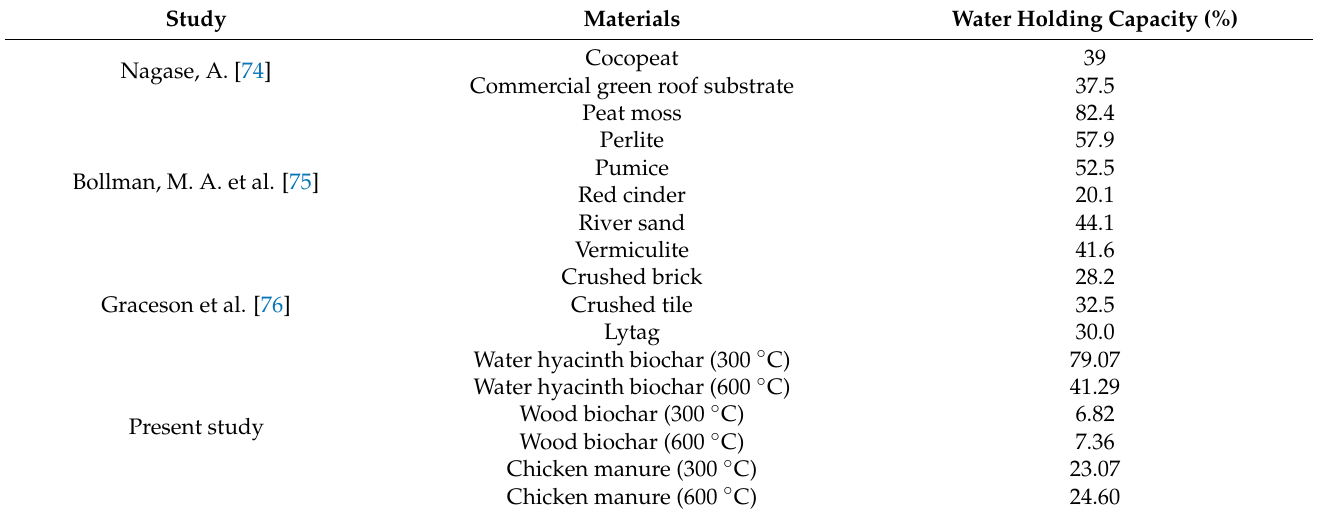
Table 7. Summary of media commonly used for green